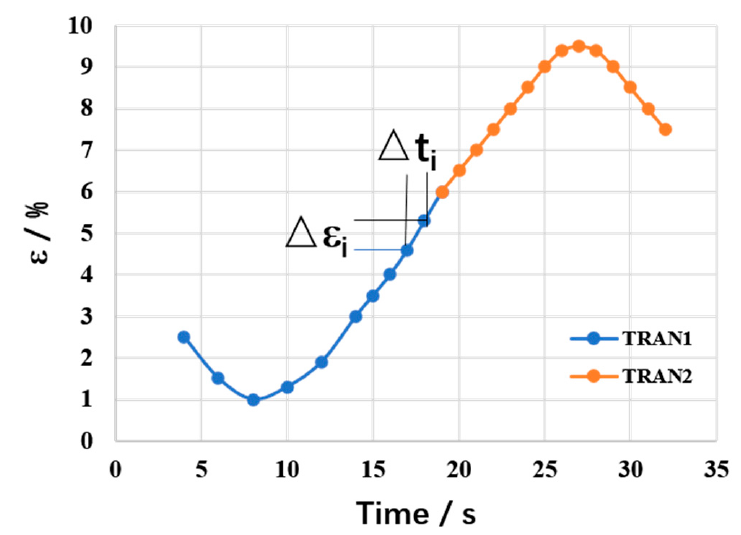
Figure 1. Diagram of the detailed strain rate increment method.